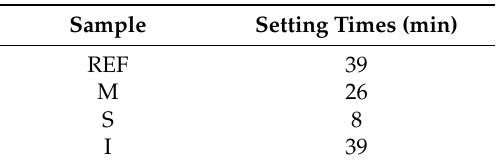
Table 3. Setting times by Vicat needle